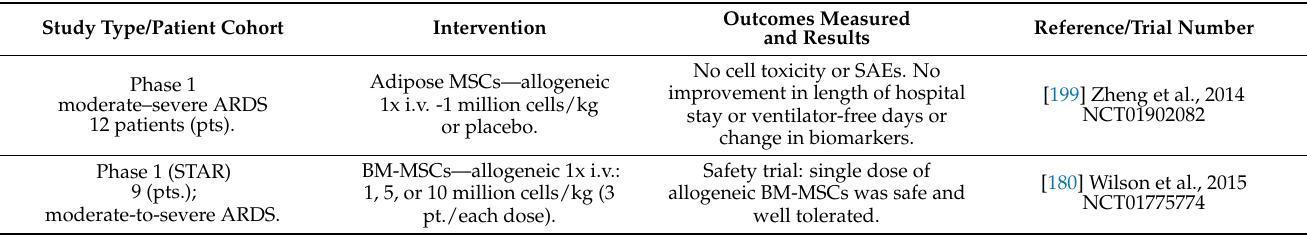
Table 3. Randomized controlled trials of MSC therapy in severe ARDS (including ARDS caused by